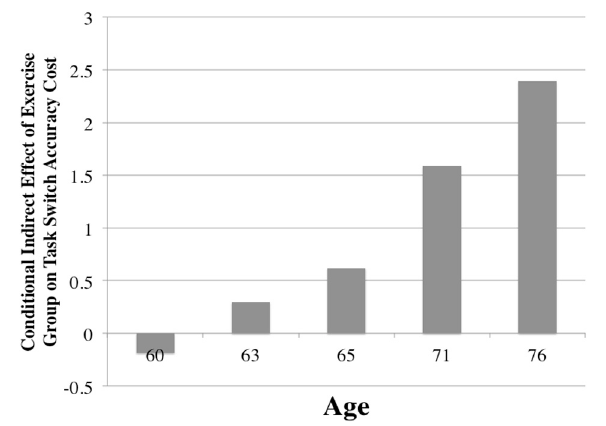
FIGURE 4 | Mediating effect of BDNF within model, as a function of age. Note: Moderated mediation conditional indirect effect. Values of the y-axis are the unstandardized mediating effects (coefficients) of BDNF on the relationship between exercise group and task switch accuracy cost. Bars indicate age quintiles (10th, 25th, 50th, 75th, and 90th percentiles) on the x-axis. Sample distribution is as follows: Age < 60: n = 13; 61–63: n = 21; 64–65; n = 12; 66–71: n = 23; 71–76: n = 16; > 77: n =